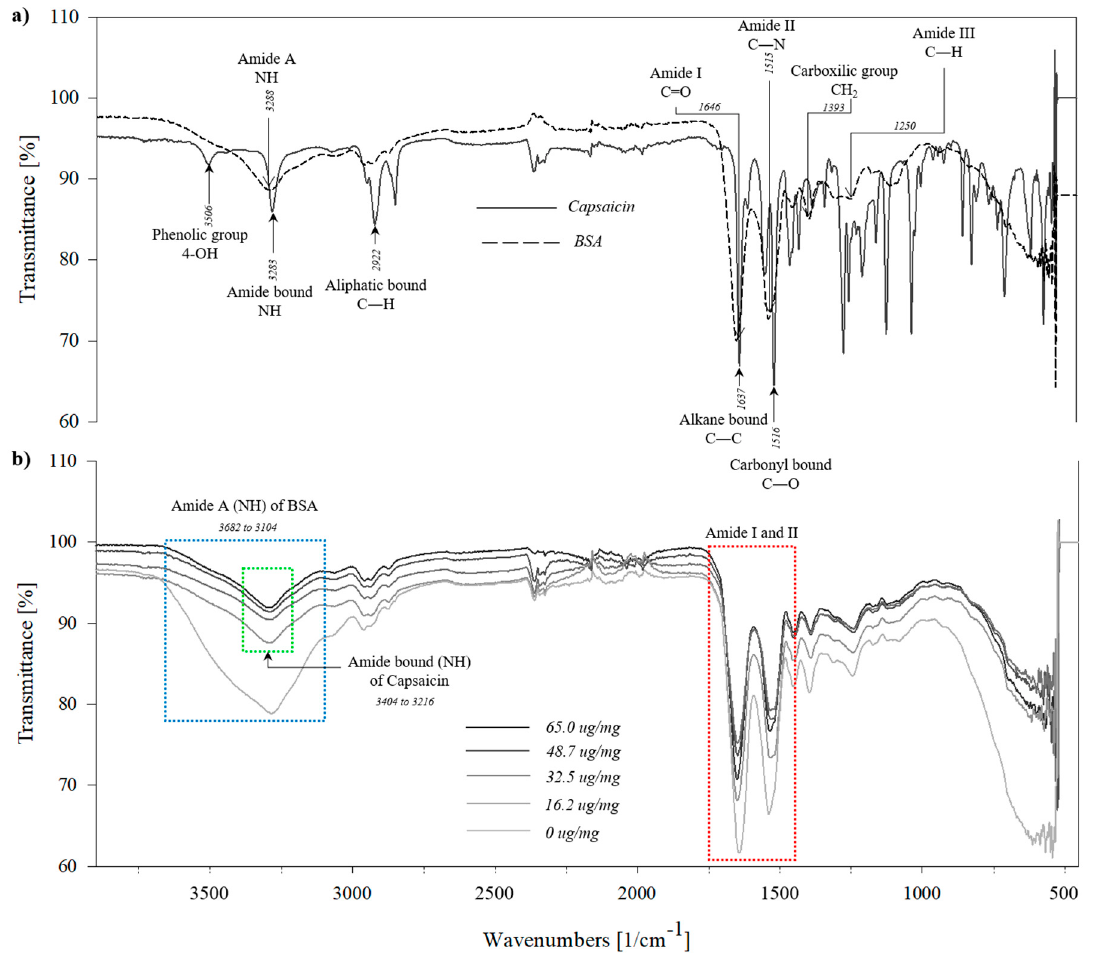
Figure 3. FTIR characterization of the BSA–capsaicin pure molecules and the effect of the increment of capsaicin in the nanostructure formation. ( a ) FTIR spectral characterization of BSA and capsaicin; the scanning spectral range was between 650–4000 cm − 1 . ( b ) Spectral graphs of the BSA-capsaicin nanoparticles at 0, 16.4, 32.5, 48.7 and 65.0 µg/mg, (lines in gradient of grey). The treatments showed between 3682 to 3104 cm − 1 a deformation of the peak that corresponds to N–H stretching (rectangle blue), and the second region is the amide I and amide II of the BSA with the hydrophobic side chain of the capsaicin, from 1710–1126 cm − 1 .